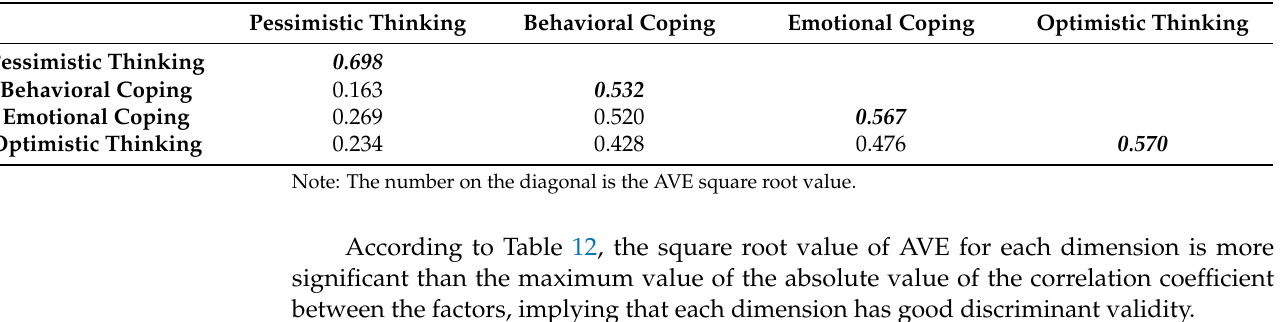
Table 12. Discriminant validity: Pearson correlation and AVE square root